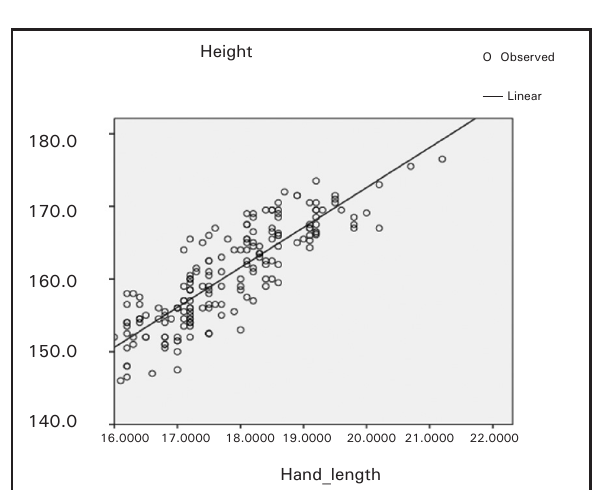
Figure 3. Regression of height on hand length for combined